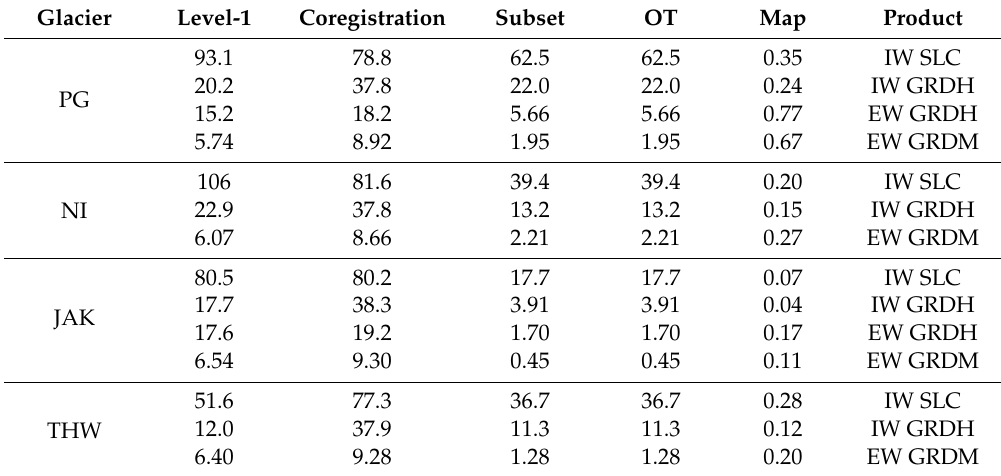
Table 15. Storage needs (in GB) per analyzed time-series, processing step, and product class. Glacier Level-1 Coregistration